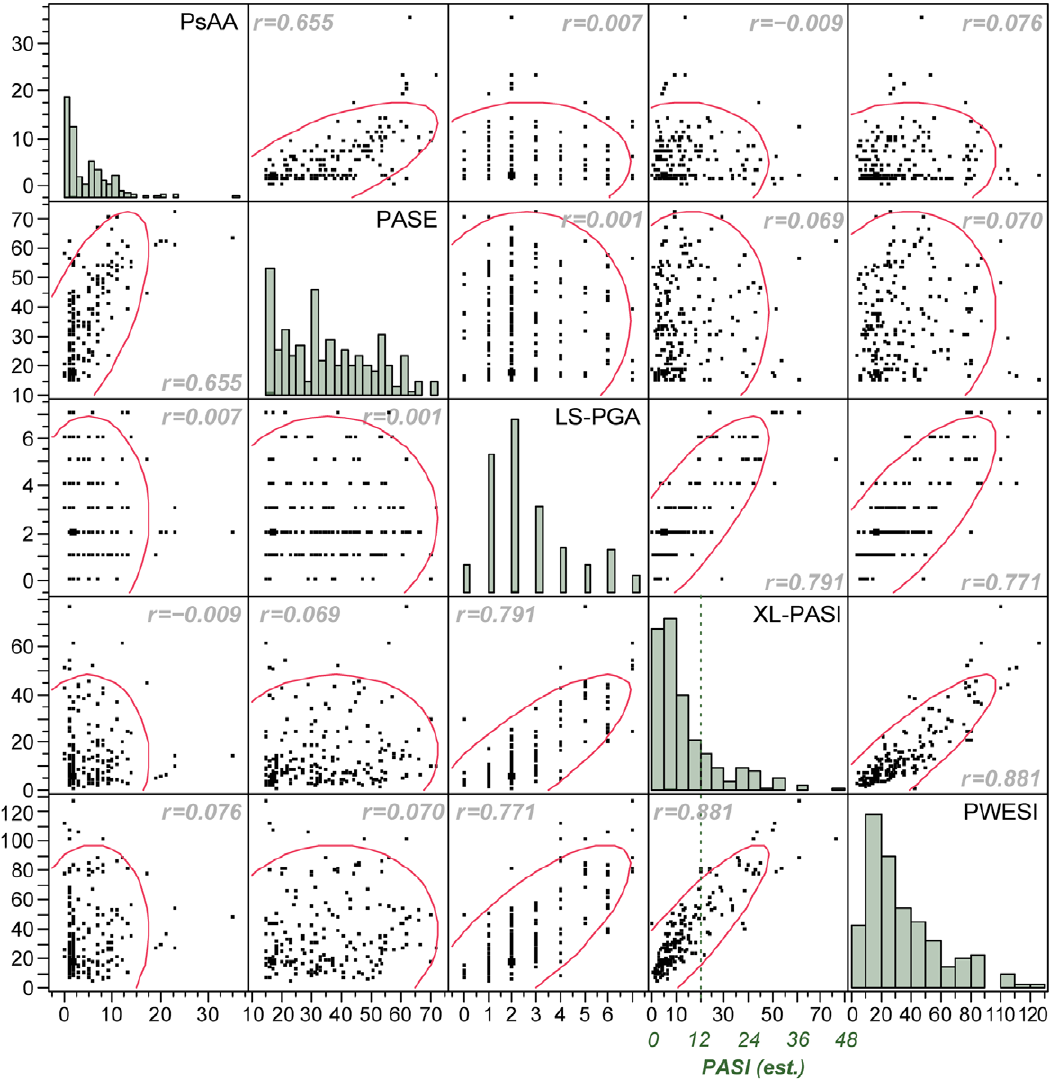
Figure 1. Correlations between tools scoring the severity of psoriasis and psoriatic arthritis and distribution of scores. x-axis and y- axis values represent the respective scores of the tools. For comparison with traditional PASI scores, the XL-PASI scores are translated into estimated PASI scores. The dotted line with an estimated PASI score of 12 separates the patients with moderate and severe disease. r: Spearman correlation.